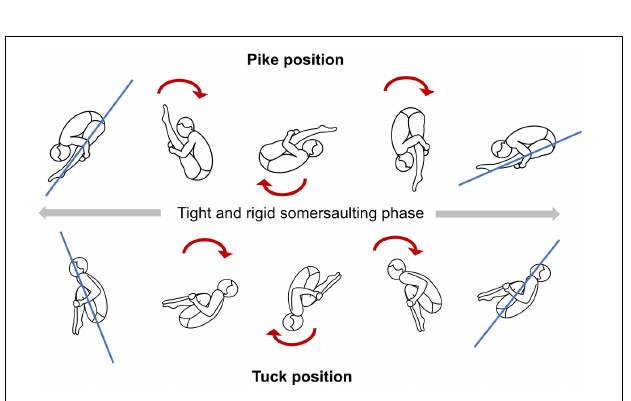
FIGURE 2 | A straight line passing through the hip and knee joints of the athletes was drawn in indicate the orientation of the athlete in the beginning and end of the tight and rigid somersaulting